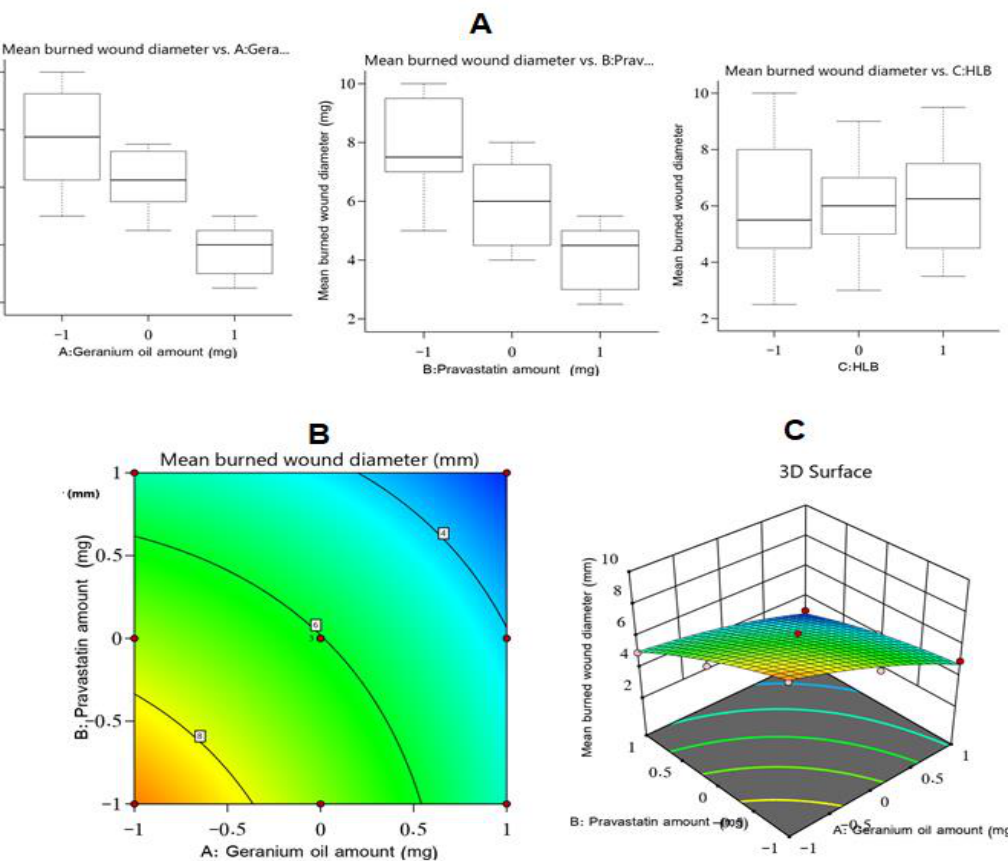
Figure 2. Main effect diagram ( A ), contour plot ( B ), and 3D surface plot ( C ) showing the effects of different independent variables on the mean burn wound diameter (Y 2 ) obtained after the application of different Gr-PV-NE formulations. Table 3. Regression analysis results for Y 1 and Y 2 responses.